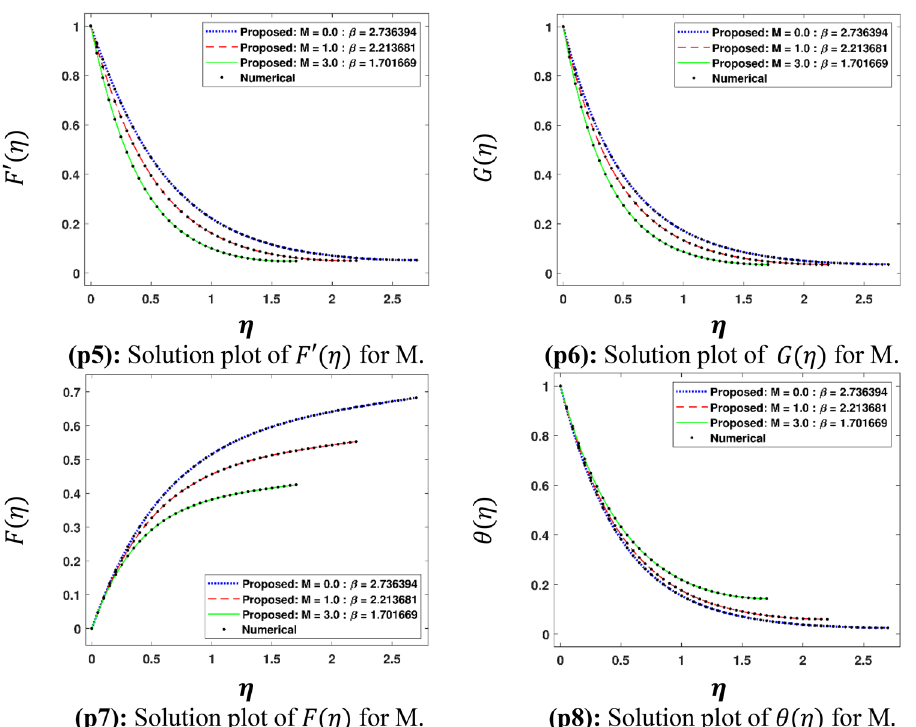
Figure 12. Solution plots of F ′ (η) , G (η) , F (η) and θ(η) by using the proposed